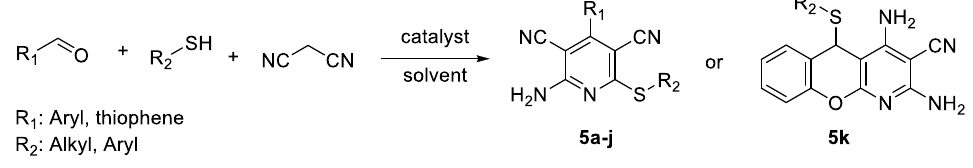
Figure 2. Enzyme-catalyzed synthesis of pyridines 5a – k .